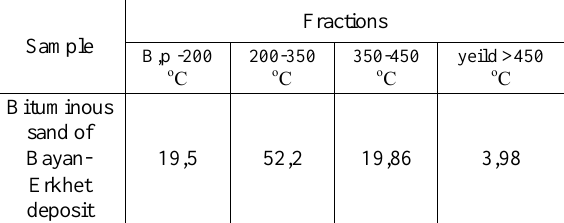
Table 6. The yield and size distribution of liquid products obtained by heat treatment of bituminous sand of Bayan-Erkhet deposit, mass.%